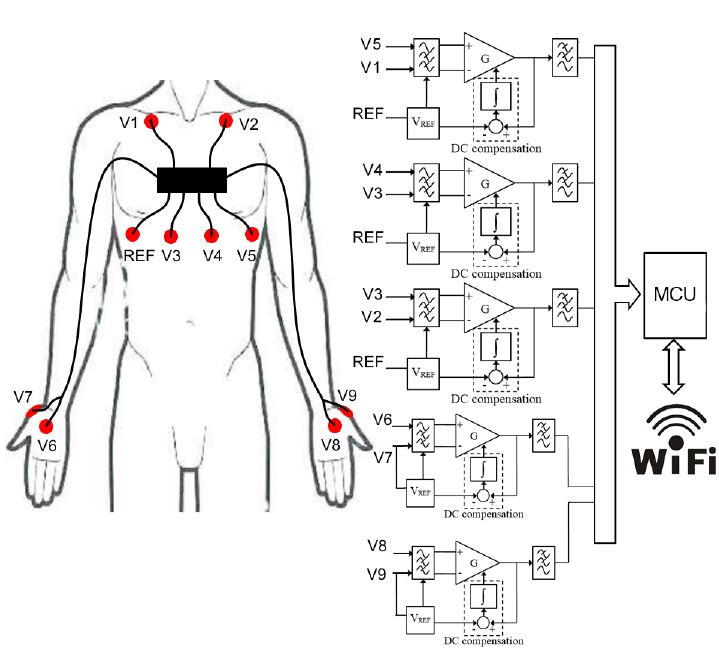
Figure 2. Electrodes arrangement and sensor block